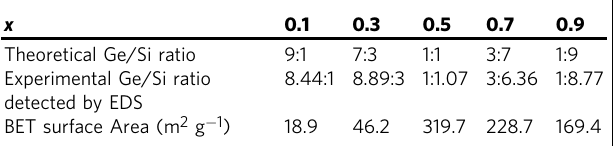
Table 1 Summary of the Ge/Si ratios and BET surface areas of 2D gersiloxenes with varying x